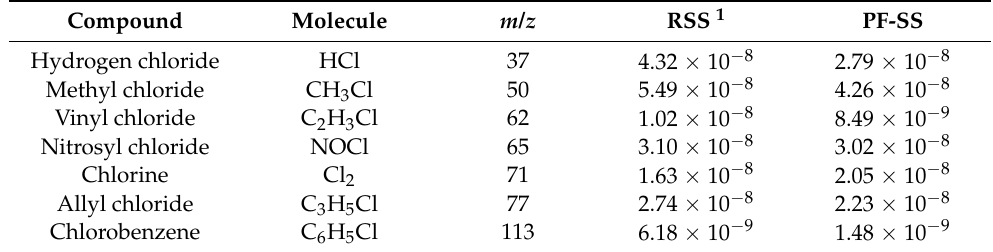
Table 5. Peak integrated areas of gaseous products containing Cl contaminants.